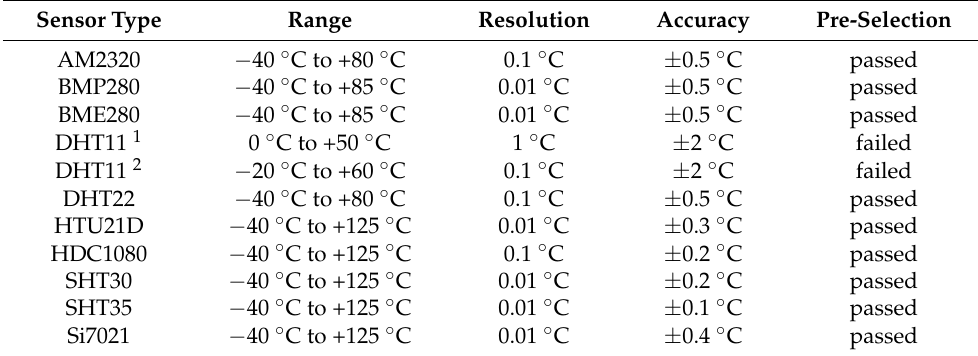
Table 5. Pre-selection of temperature